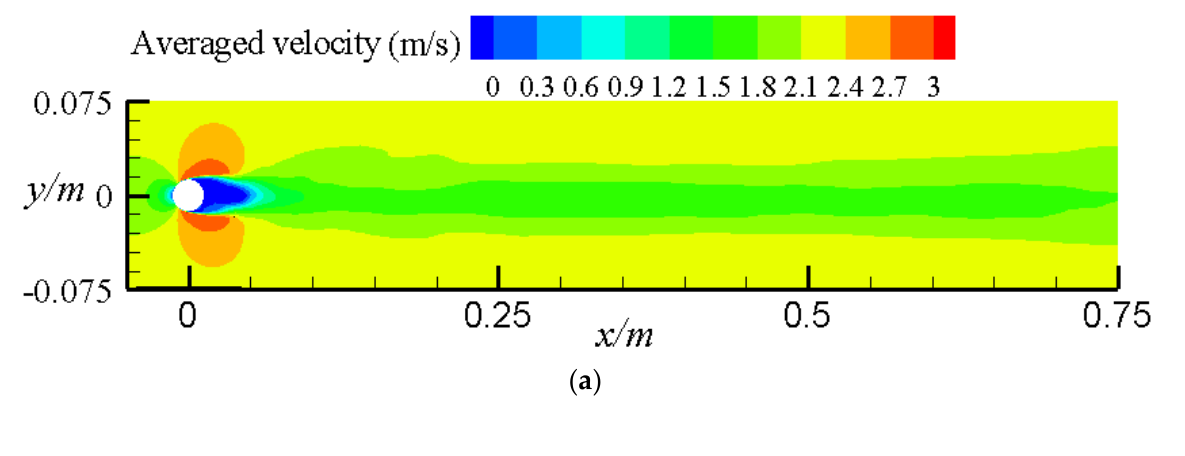
Figure 13. Power spectral density of unsteady lift